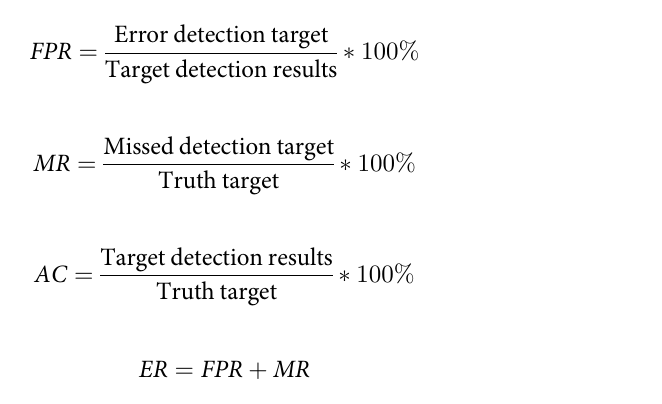
Introduction to comparison